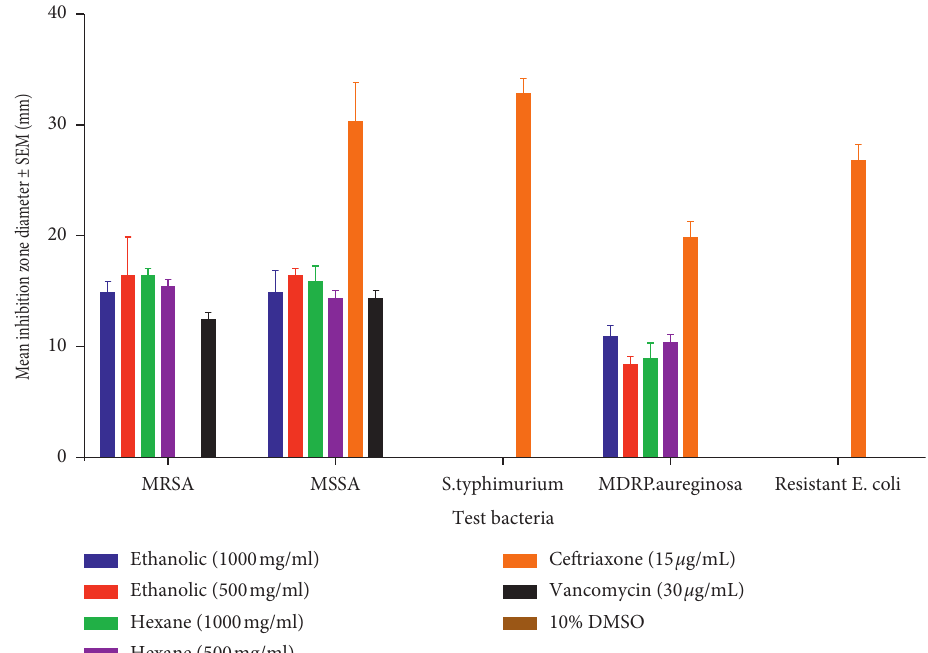
Figure 1: Comparison of mean inhibition zone diameters of the ethanolic and hexane crude extract of A. heterophyllus seeds against selected bacteria causing diarrhoea. Key: MRSA: methicillin-resistant Staphylococcus aureus , MSSA: methicillin-susceptible Staphylococcus aureus , S. typhimurium : ciprofloxacin-resistant Salmonella typhimurium , MDR PA: multidrug-resistant Pseudomonas aeruginosa , R E. coli : third- generation cephalosporin-resistant E. coli .